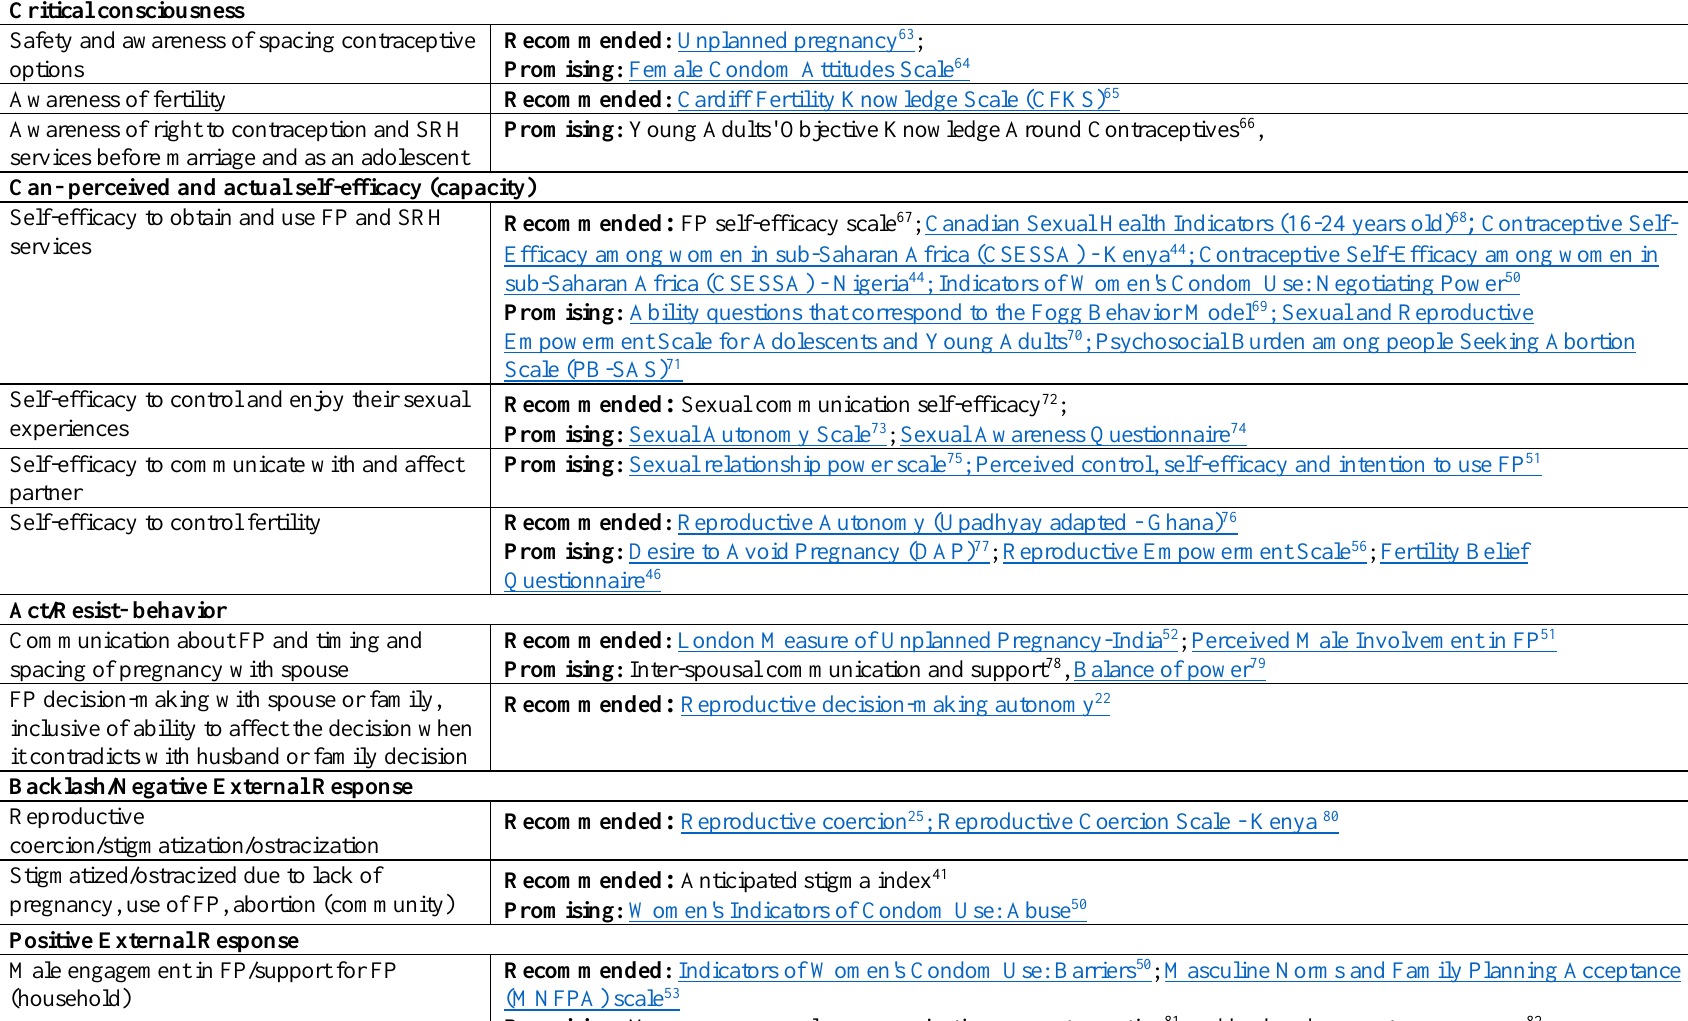
Box 2: Summary of Recommended and Promising Measures of Gender Equity in Family Planning